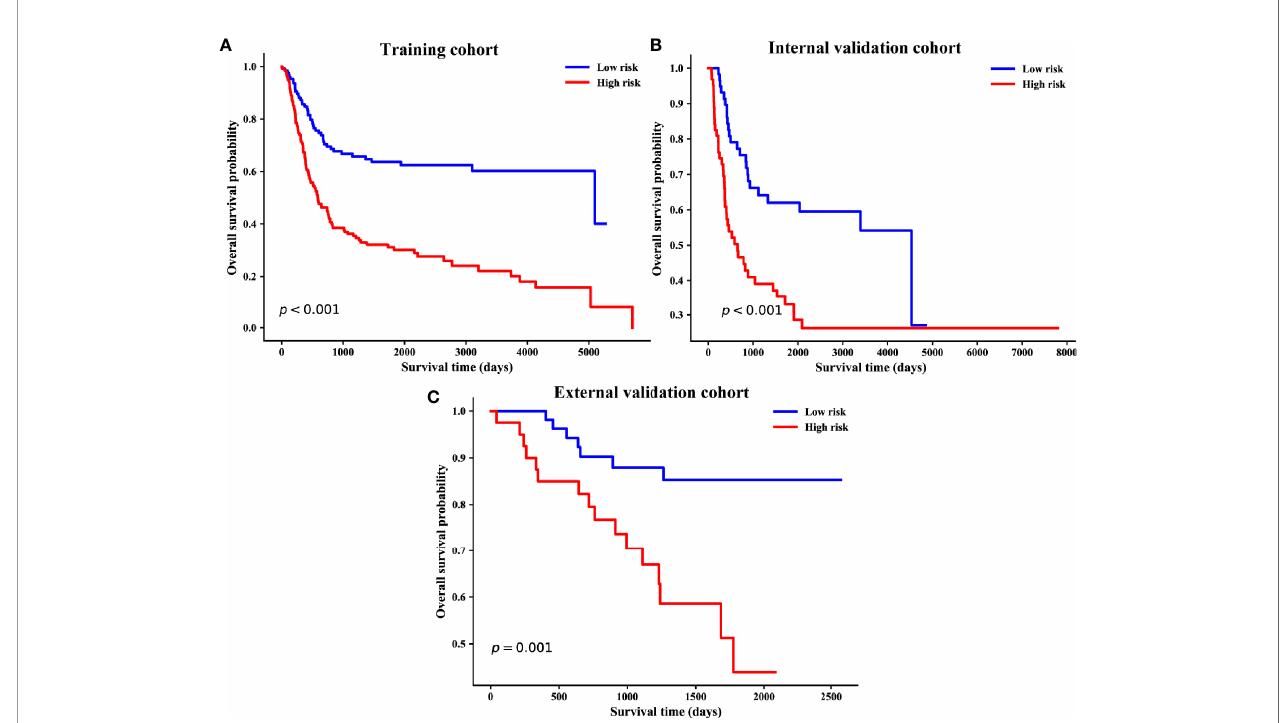
FIGURE 5 | Kaplan – Meier survival curves of overall survival based on risk score of the clinical – pathological nomogram in the training (A) , internal validation (B) and external validation cohorts (C)